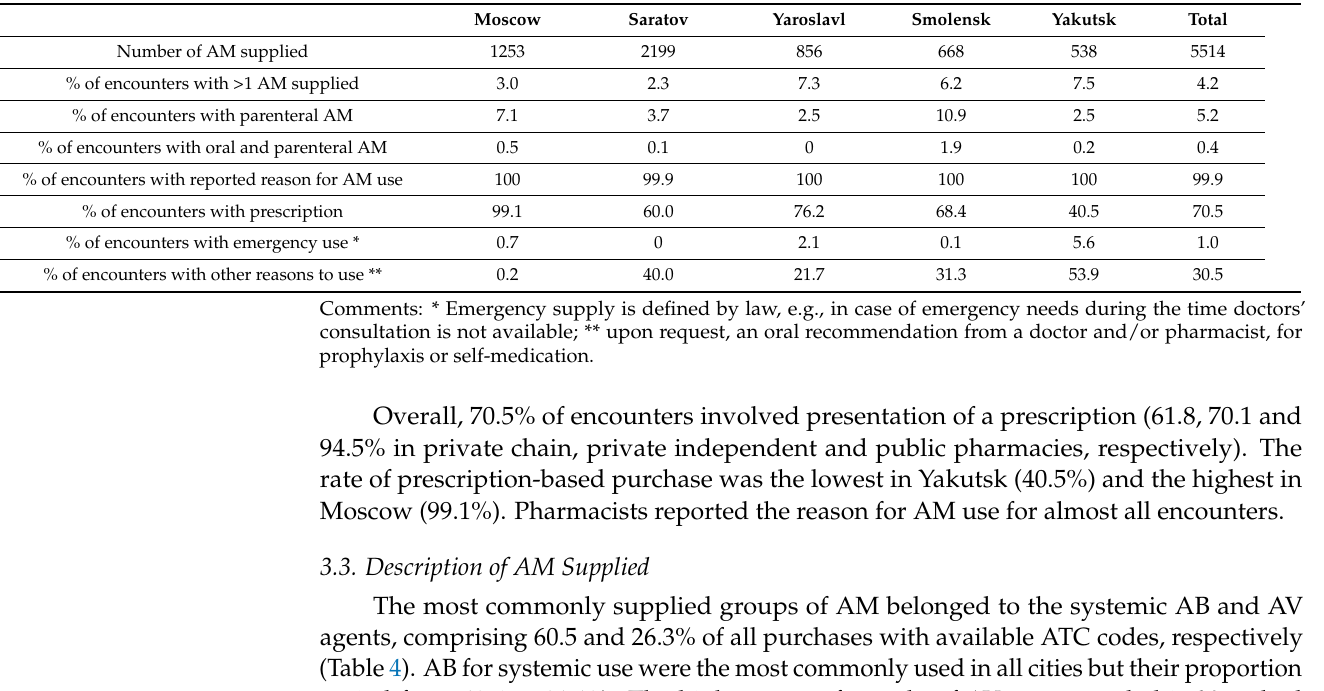
Table 3. Description of AM encounters in community